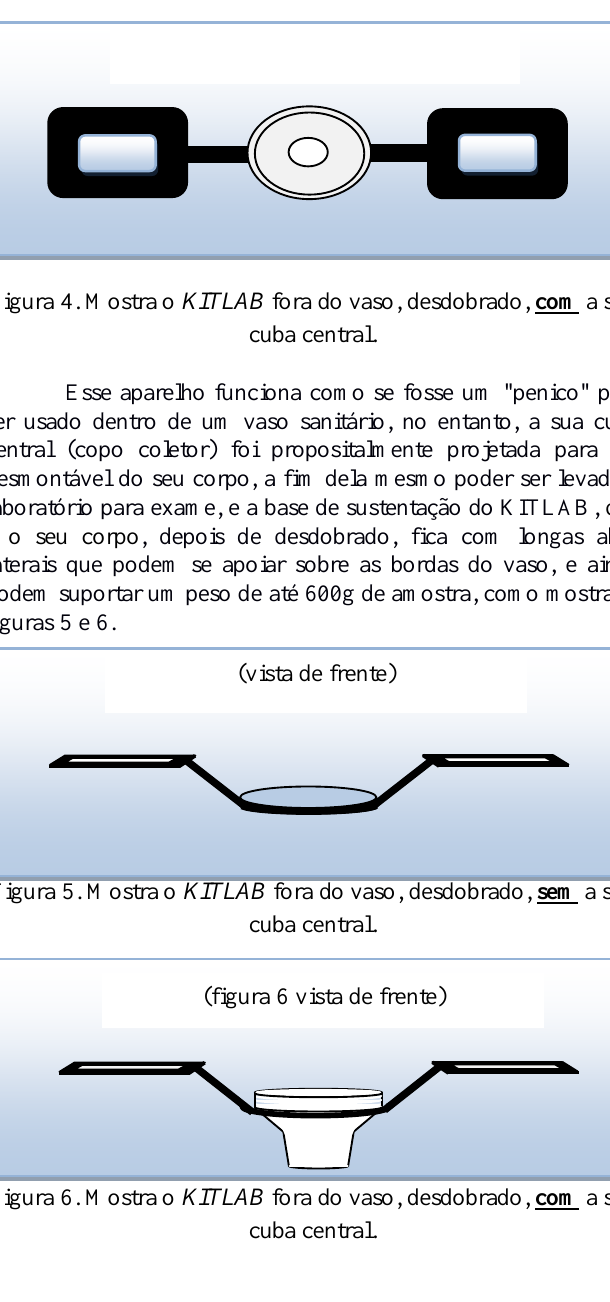
Figura 3. Mostra o KITLAB fora do vaso, desdobrado, sem a sua cuba central.